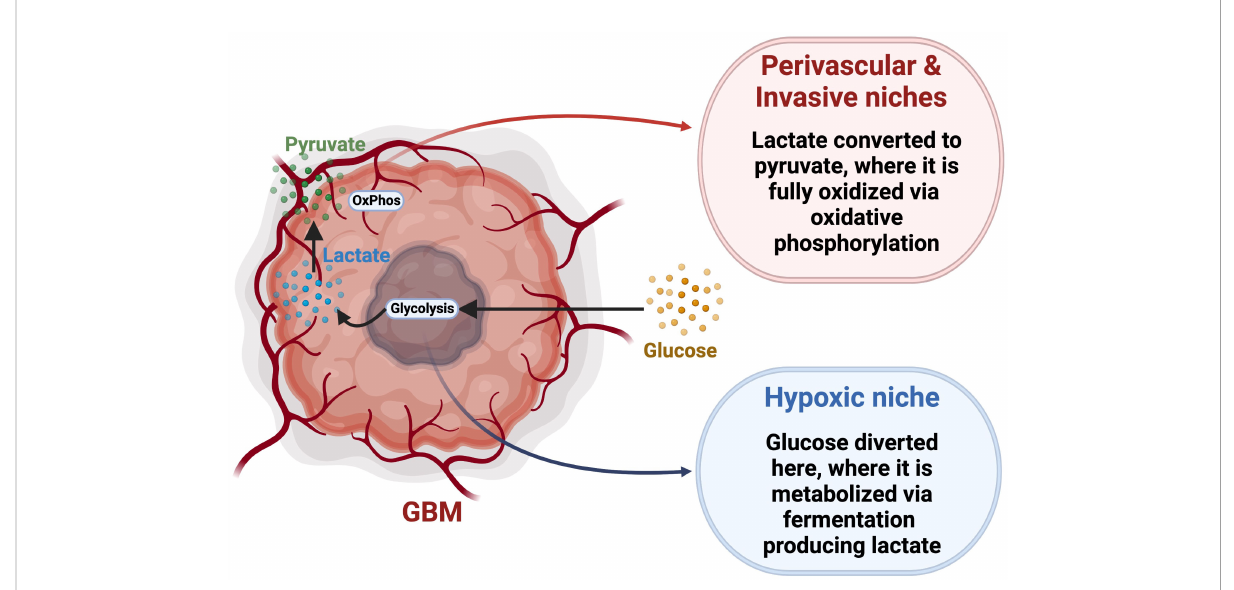
FIGURE 3 Reverse Warburg Effect hypothesis. This model proposes a speci fi c metabolic interplay between glycolytic and oxidative tumor niches via traf fi cking and conversion of glucose, lactate and pyruvate. Adapted from “ Cancer Metabolism ” , by BioRender.com (2022). Retrieved from